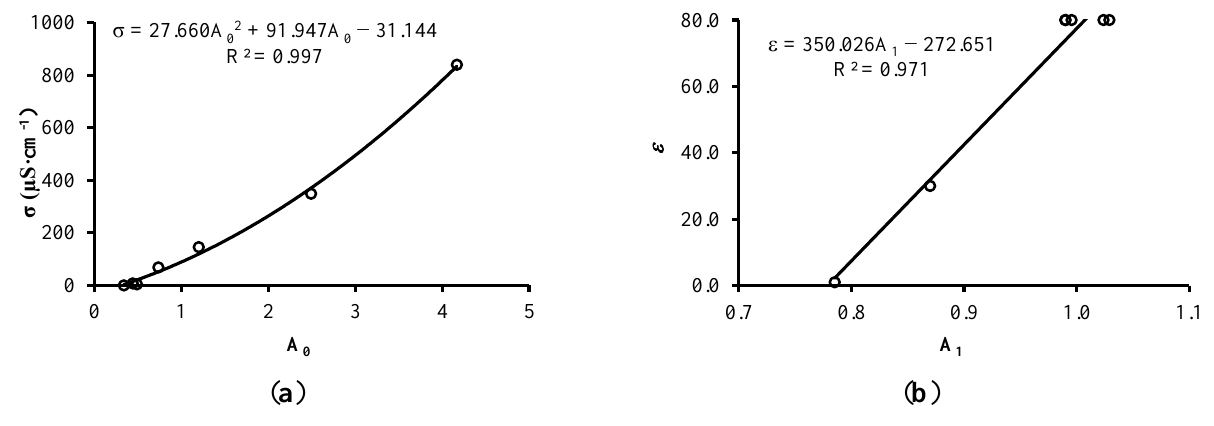
Figure 5. Relationships between σ-A 0 ( a ) and ε - A 1 ( b ).